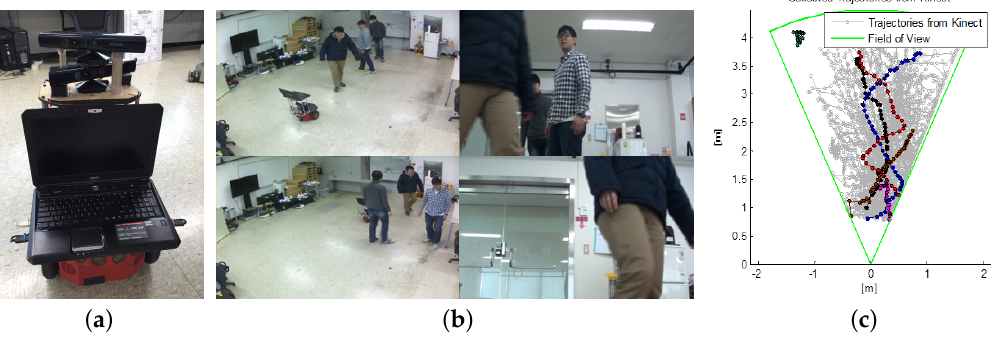
Figure 6. ( a ) A mobile robot equipped with two Kinect cameras; ( b ) snapshots from an experiment in a human–robot environment, where the first column is a third-person view, while second column is the egocentric view of a robot; and ( c ) collected trajectories [23] (reproduced with permission from Eunwoo Kim, Sungjoon Choi, Songhwai Oh, A Robust Autoregressive Gaussian Process Motion Model Using l 1 -Norm Based Low-Rank Kernel Matrix Approximation; published by IEEE 2014). For better visualization, we represent some trajectories in